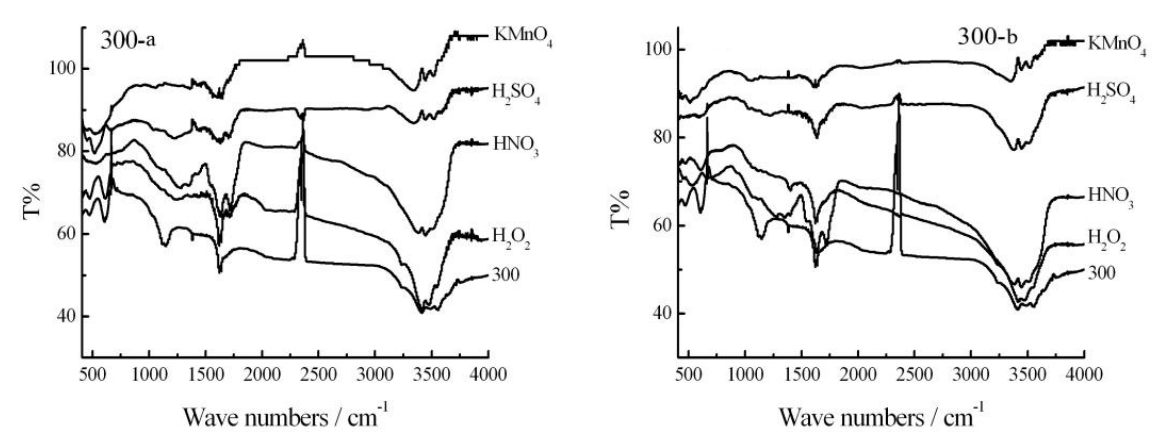
Figure 1: FTIR spectra of biochar obtained at 300 o C before and after modification (a. Dipping, b. Ultrasonic dipping).